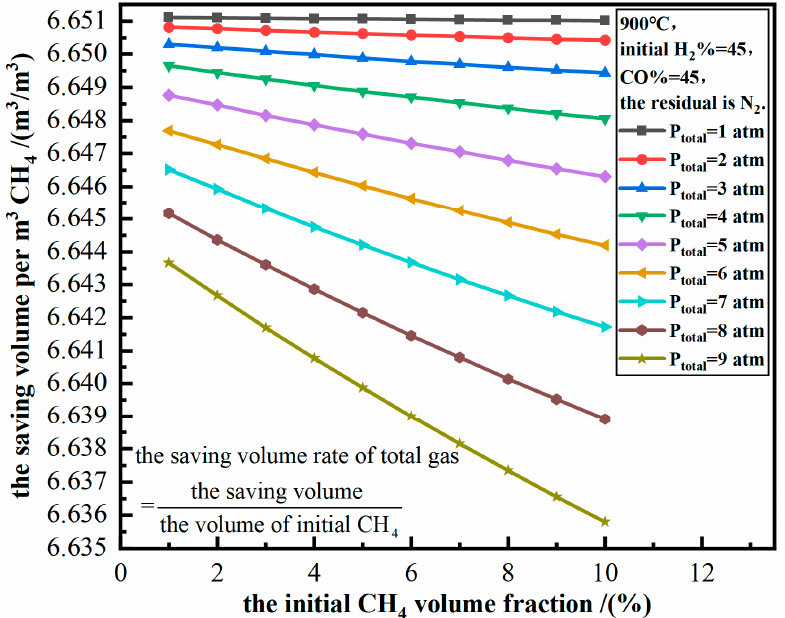
Figure 6. The relationship between the saving volume per m 3 CH 4 and initial CH 4 volume fraction at 900 °C with the initial H 2 % = 45 and CO% = 45 under 1–9 atm.